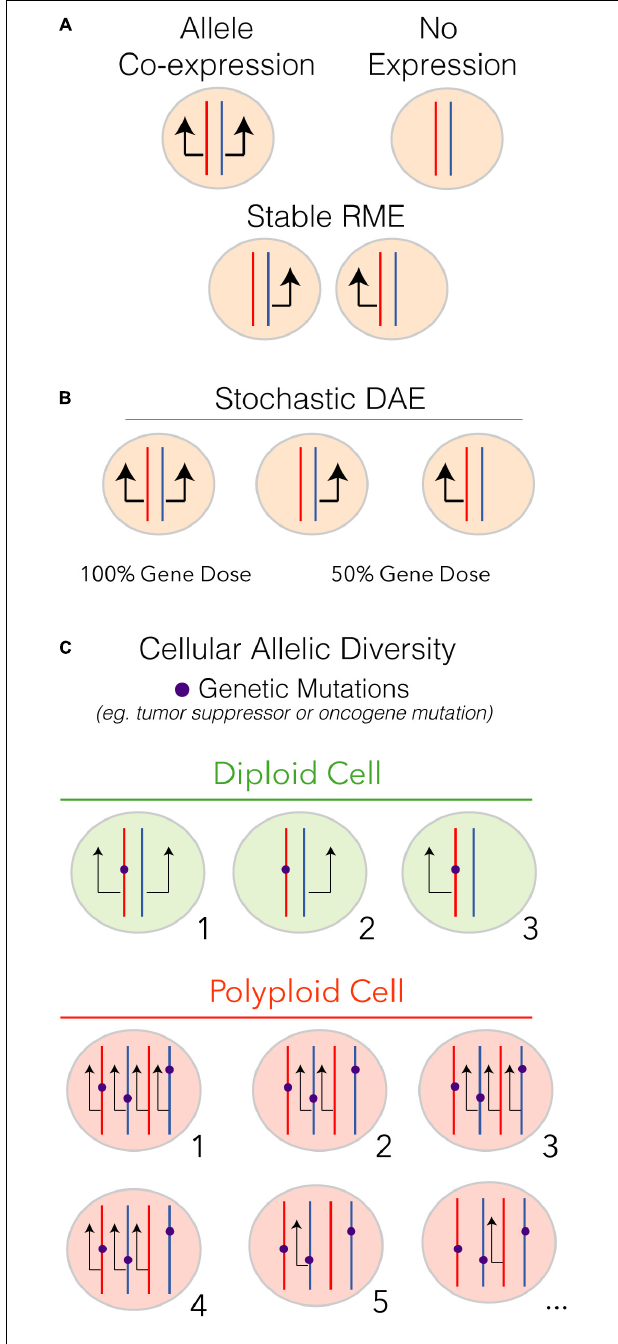
FIGURE 2 | Allele-specific epigenetic and expression create complex and diverse cellular states. (A) Classic biallelic (allele co-expression) and no expression states typically associated with autosomal genes, and clonal random monoallelic states (RME) typically associated with random X-inactivation in females. (B) Newly described stochastic differential allele expression (DAE), which causes biallelic and stochastic allelic expression states at the cellular level for thousands of autosomal genes in mice. (C) DAE interacts with heterozygous mutations in diploid and polyploidy cells to create widespread cellular diversity and potential for adaptability to different conditions. This phenomenon could be a major blocker to cancer cell